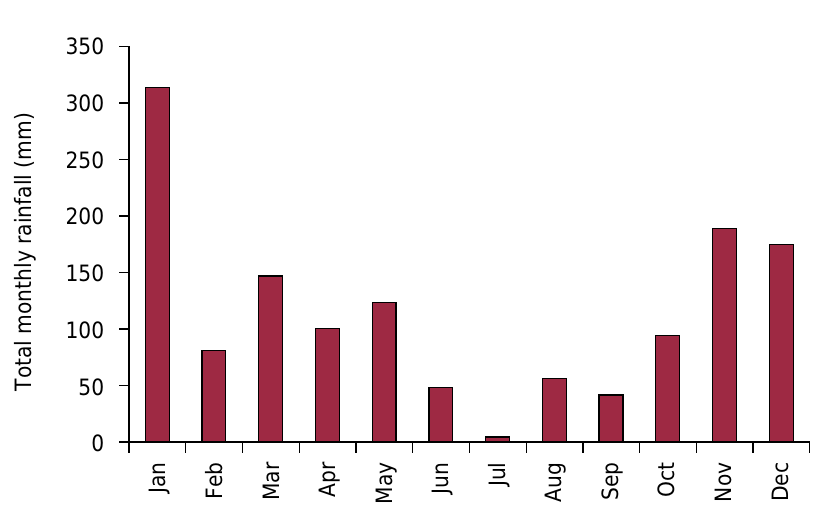
Figure 3. Distribution of total monthly rainfall (mean of the values obtained from the stations, codes 2246168, 2246169, 2246167, 2246171, 2246170, and 2246175, distributed across the Posses catchment) for the year